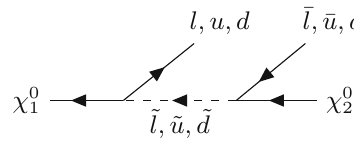
Fig. 2 L conserving decays of χ 0